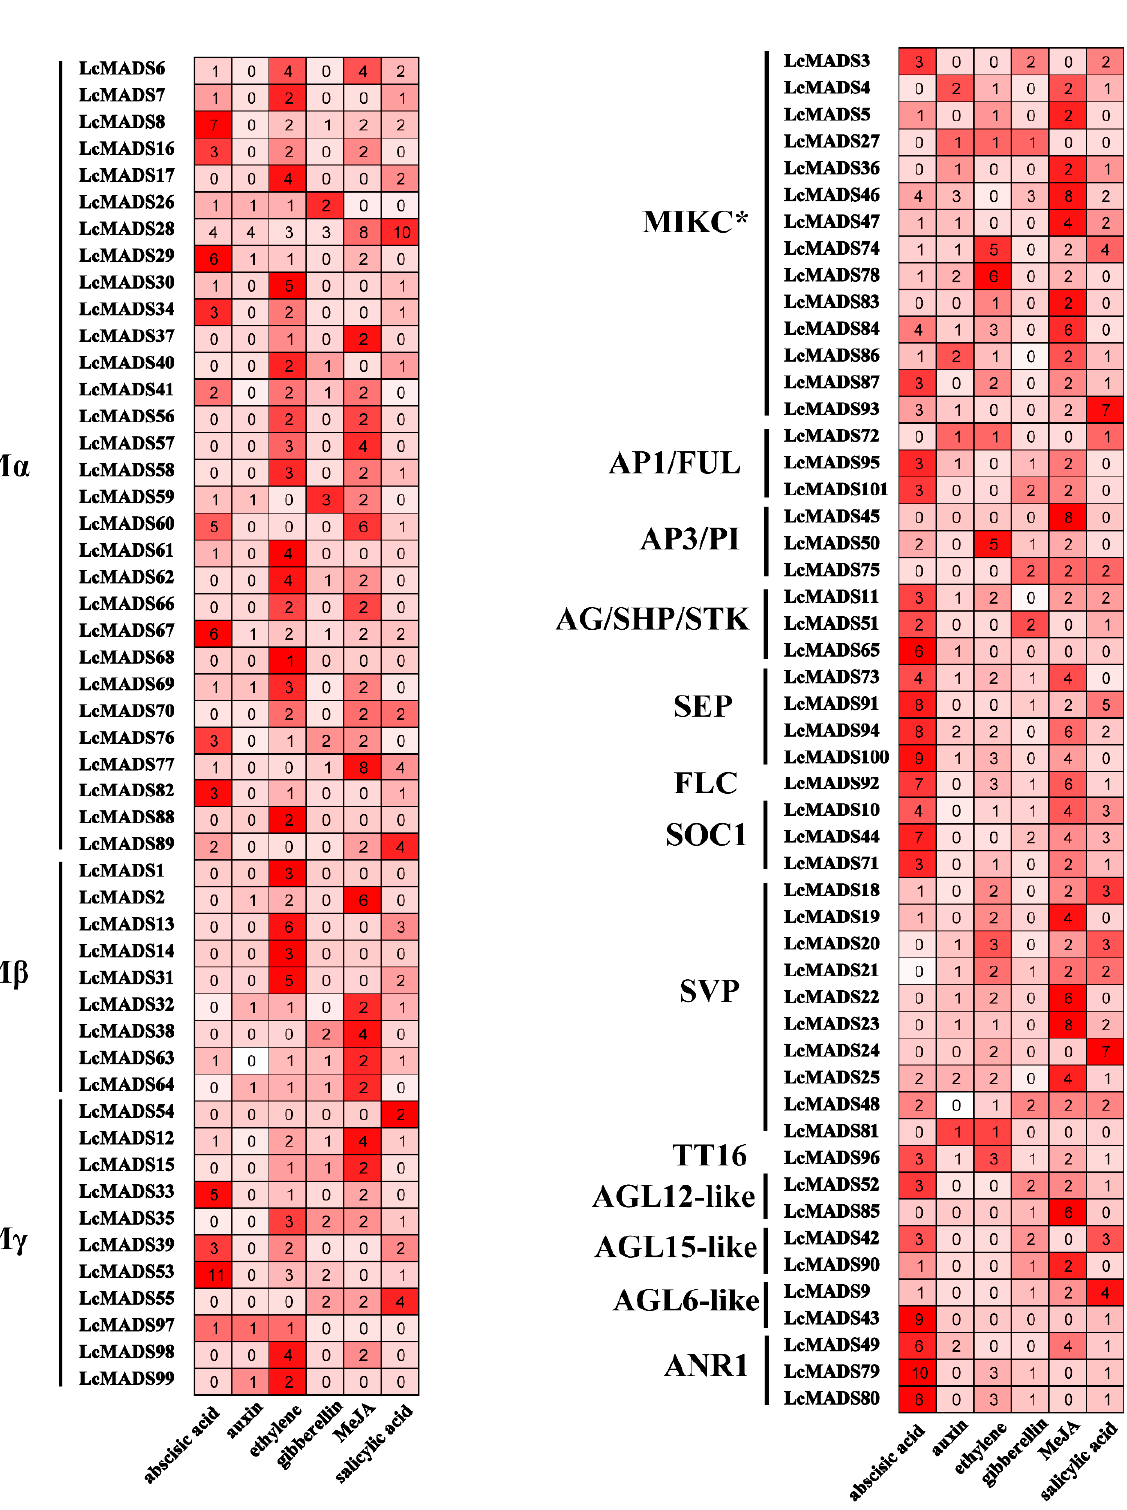
Figure 8. Predicted cis-elements in promoters of litchi MADS-box genes using PlantCARE. The numbers of abscisic acid, auxin, gibberellin, MeJA, salicylic acid, and ethylene related cis-elements are indicated. Type I genes are shown on the left and type II genes are shown on the right.